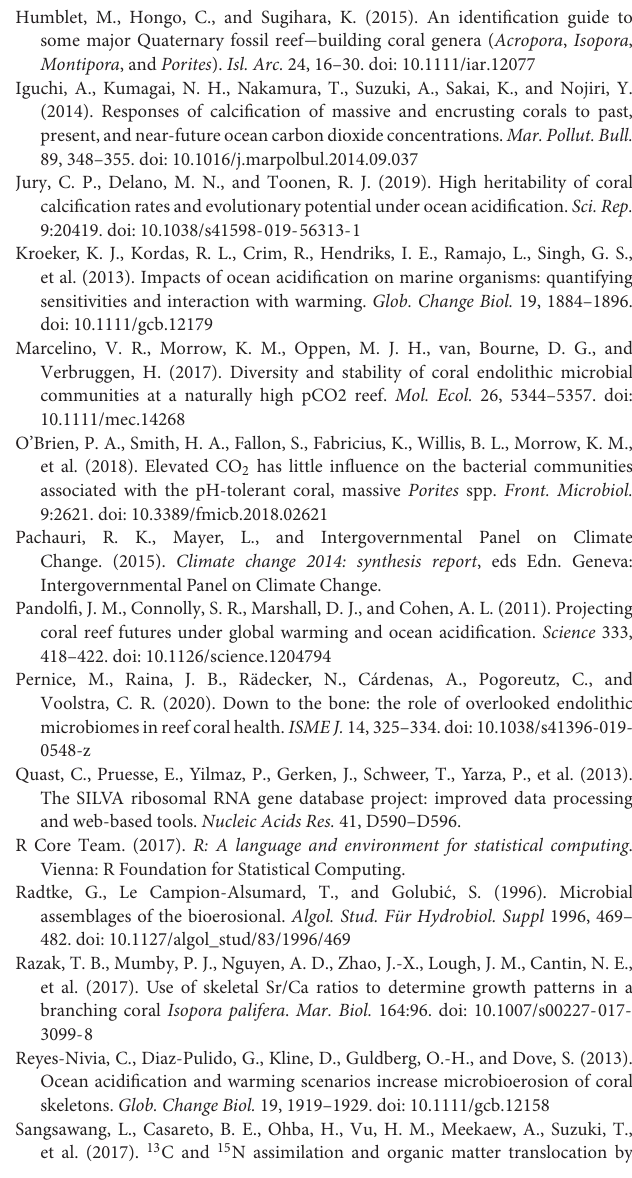
circles represent the first and second sampling times, respectively. All the sample replicates are plotted. Supplementary Figure 2 | The Venn diagram of OTU (up) and family (down) for each treatment group. Supplementary Figure 3 | Order level of the relatively abundant of (A) Alphaproteobacteria , (B) Gammaproteobacteria , and (C) Deltaproteobacteria in each treatment. IC, I. palifera control treatment; IA, I. palifera acidification treatment; PC, P. lobata control treatment; PA, P. lobata acidification treatment. Supplementary Figure 4 | Shannon diversity boxplot of the endolithic bacterial communities in the (A) Isopora palifera and (B) Porites lobata colonies under two p CO 2 treatments and two sampling points. Green indicates the control treatment and orange indicates the acidification treatment. Supplementary Figure 5 | The relatively abundant in family level for all